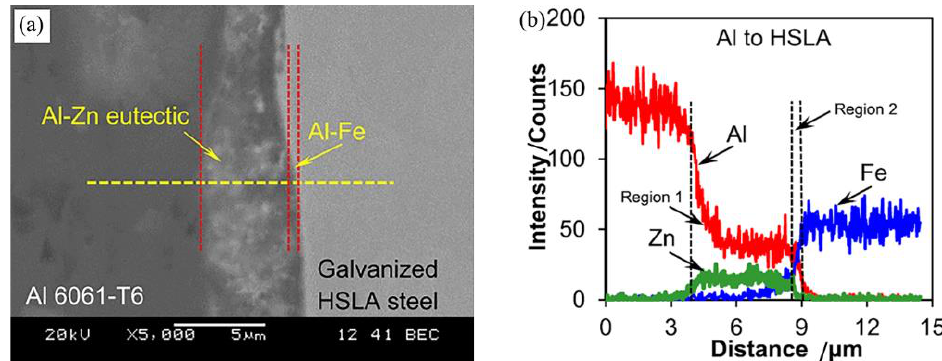
Figure 17. Microstructure of welding interface between aluminum alloy and galvanized steel [38]: ( a ) SEM images of the IMC reaction layers; ( b ) Results from EDX composition line scans.